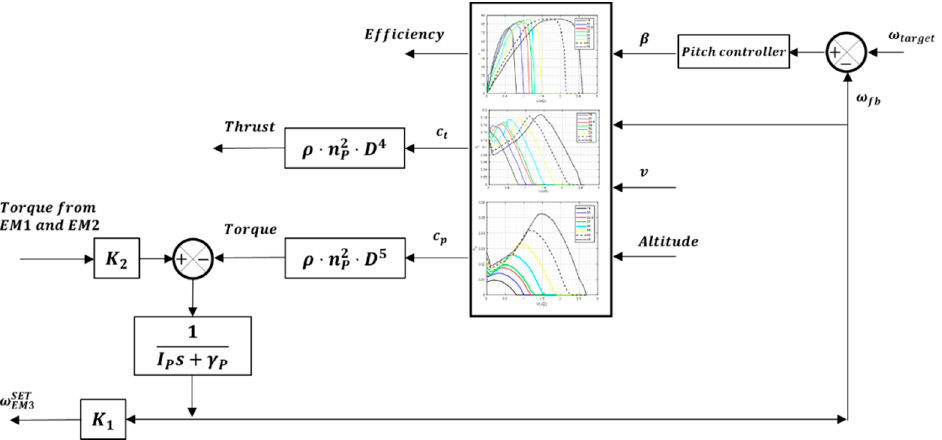
Figure 7. Schematics of the propeller model.